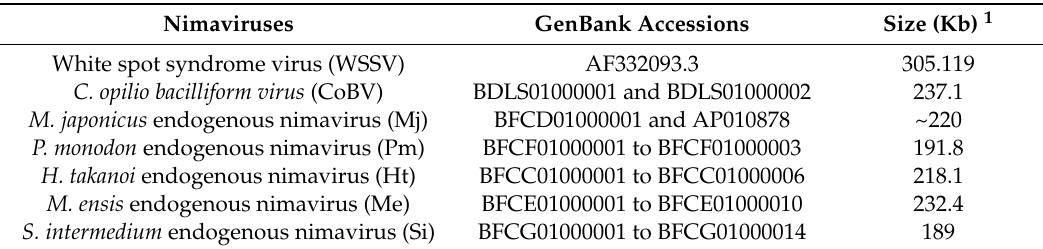
Table 1. Seven representative nimaviruses of the seven major phylogenetic